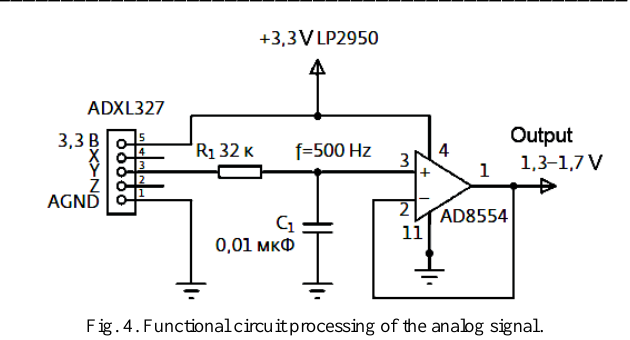
Fig. 4. Functional circuit processing of the analog signal.